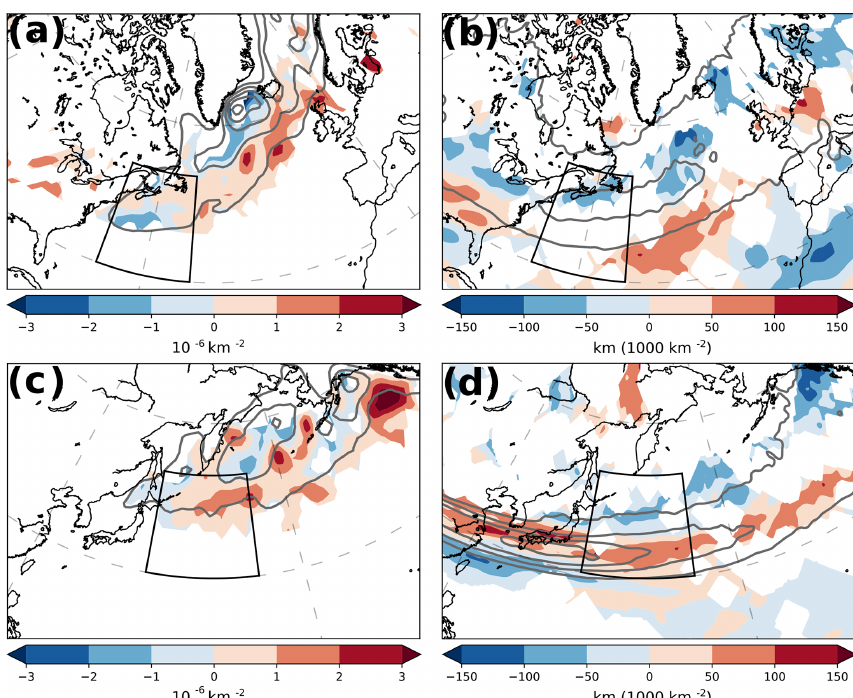
Figure 4. (a) Statistically significant ( > 95%, based on the chi-square test) difference in climatological cyclone density (SMTHG–CNTL, shading, 10 − 6 km − 2 ) and climatological cyclone density for CNTL (contours, first contour: 6 × 10 − 6 km − 2 , interval 3 × 10 − 6 km − 2 ). (b) Statistically significant ( > 95%, based on the chi-square test) difference in climatological jet stream density (SMTHG–CNTL, shading, kilometre of jet axis line (1000km) − 2 ) and climatological jet stream density for CNTL (contours, first contour: 400km of jet axis line (1000km) − 2 , interval: 200km of jet axis line (1000km) − 2 ). (c, d) As panels (a) and (b) but for the North